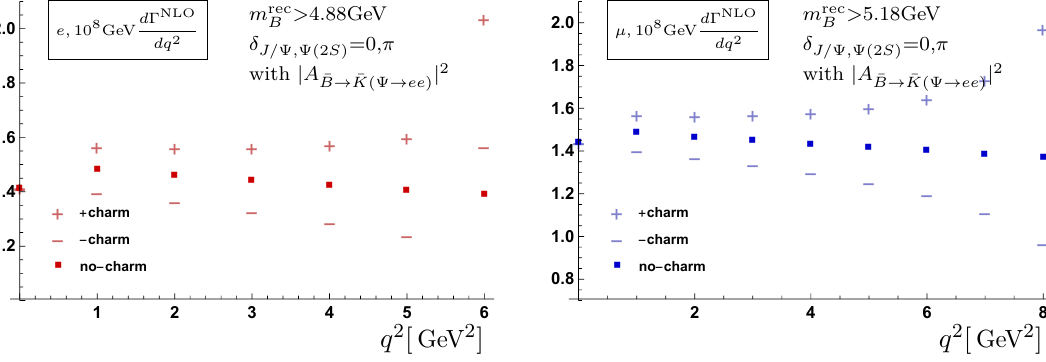
Figure 9 . Same plots as in figure 6 without